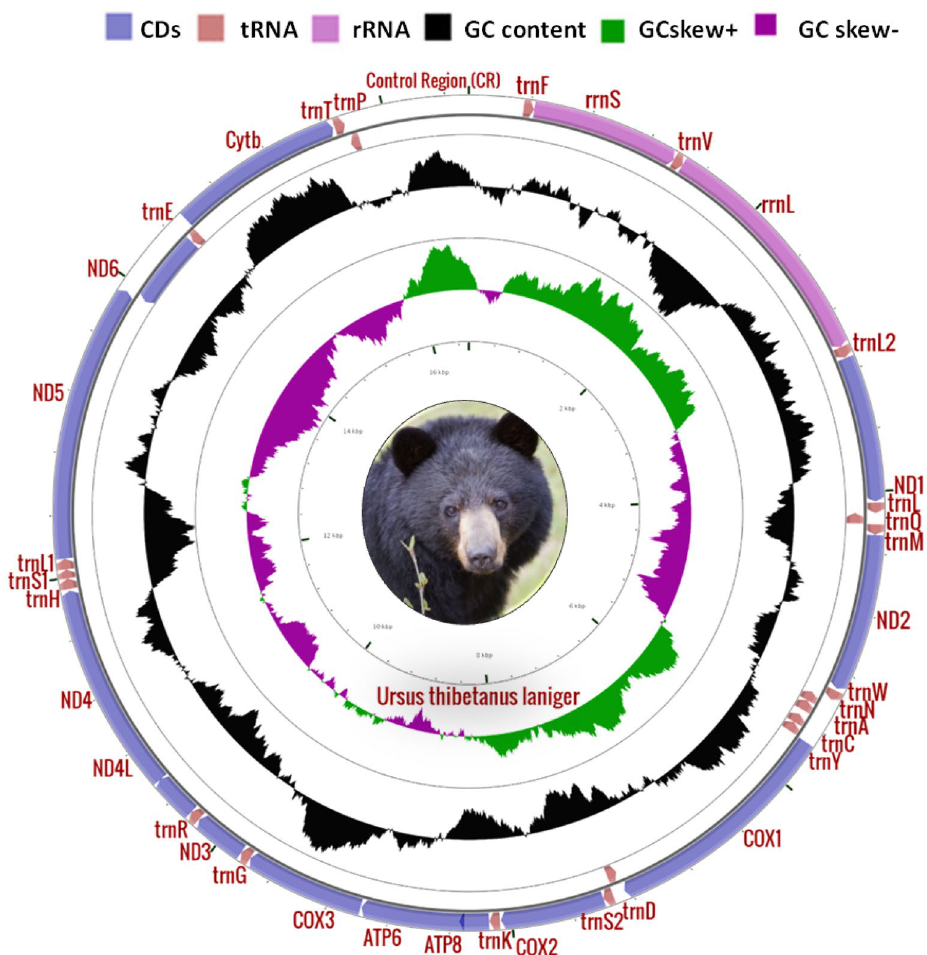
Figure 2. The mitochondrial genome of Ursus thibetanus laniger. Direction of gene signal is indicated by arrows. Protein-coding genes are shown in silver color arrows, rRNA genes in purple color arrows, tRNA genes in light pink color arrows and non-coding region in white color. The GC content is plotted using a black color; GC-skew is plotted using green and dark pink color. The figure was drawn using CGView online server (https :// stoth ard.afns.ualbe rta.ca/cgvie w_serve r/) with default